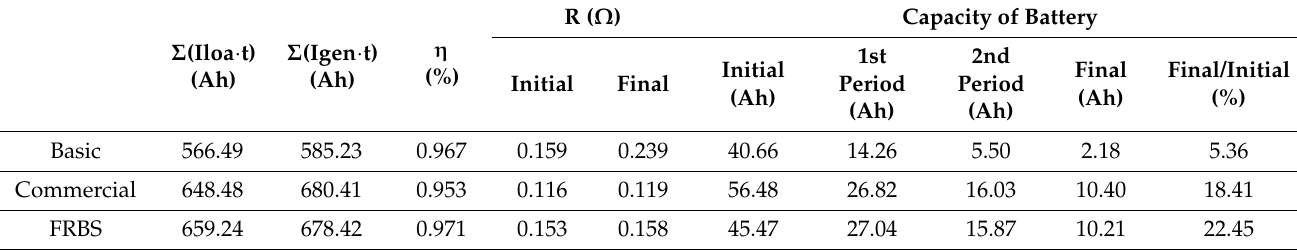
Table 1. Results of the first experiment with type A batteries.